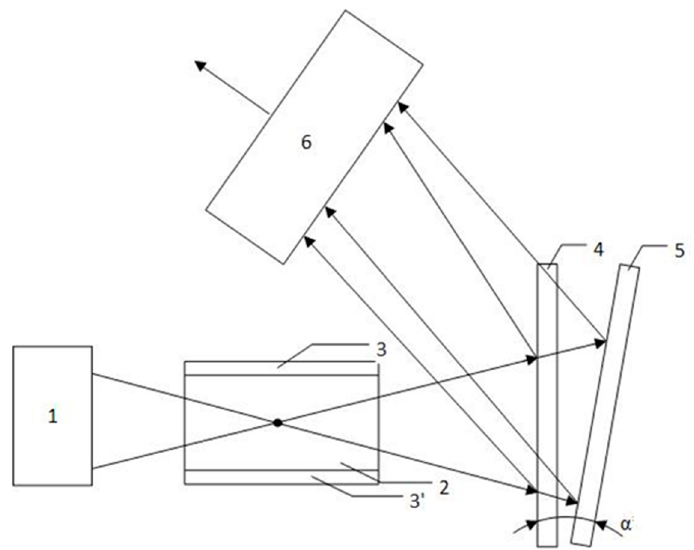
Figure 1. Block diagram of an optoelectronic device for measuring radio signal samples.